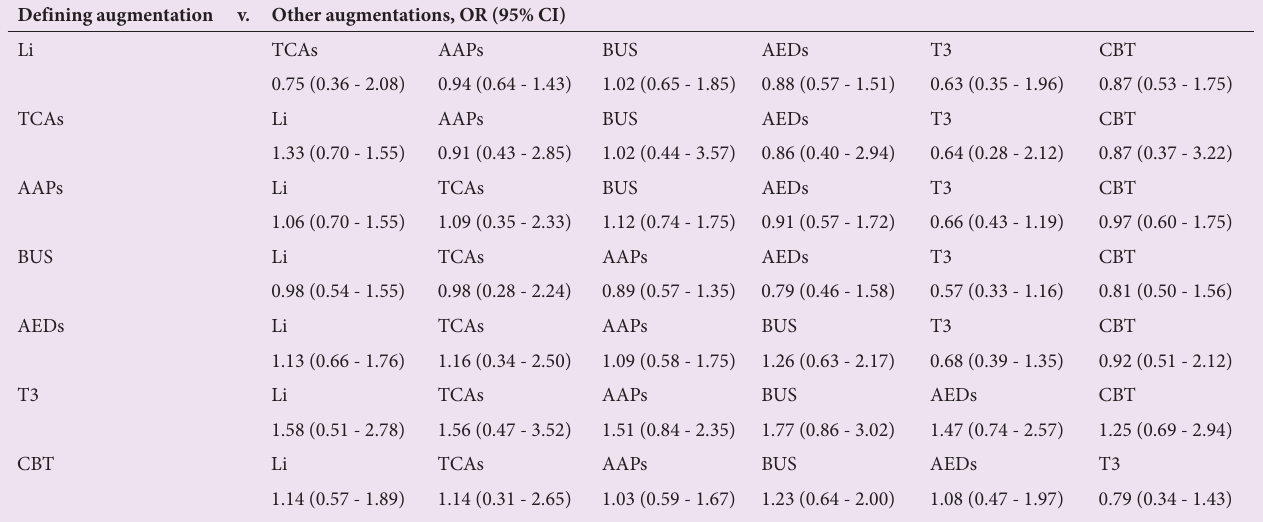
Table 2. Efficacy of seven augmentations* Defining augmentation v. Other augmentations, OR (95%